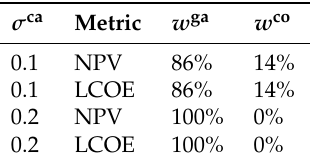
Table 12. The composition of minimum variance portfolios: The two-asset case.